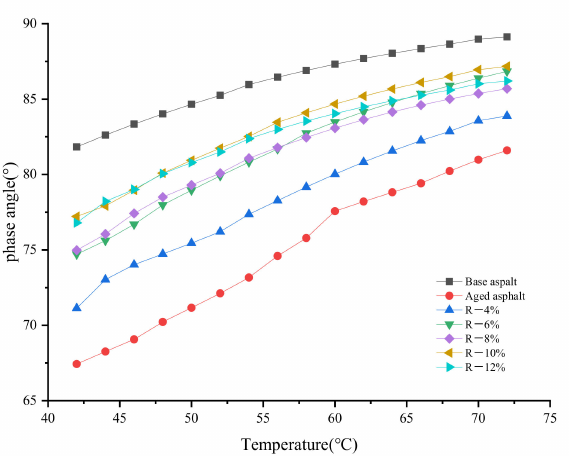
Figure 2. Test results of phase angle ( δ ) of aged asphalt after the